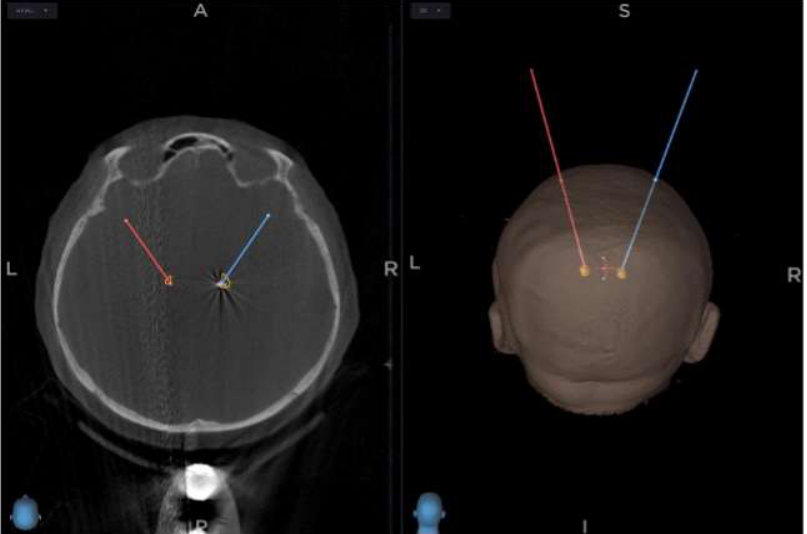
Figure 3. Final position of the lead within the STN nucleus on the right side controlled intraoperatively with O-arm scan fused to preoperative plan (red line—trajectory on the left side, blue line—trajectory on the right side, A—anterior, P—posterior, R—right, L—left, S—superior, I—inferior, yellow— subthalamic